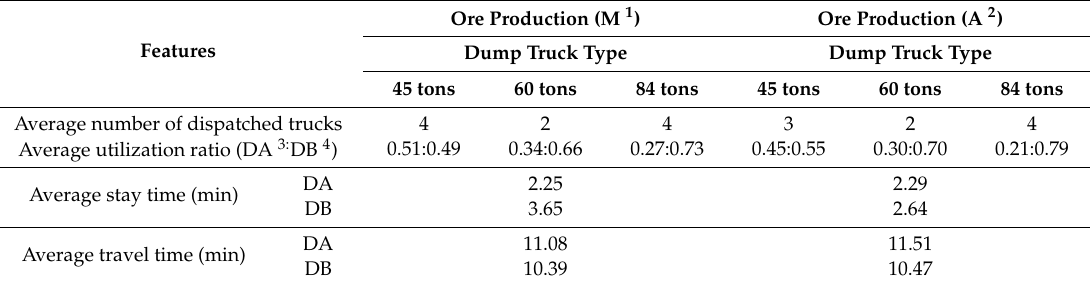
Table 2. Results of statistical analysis of training data.